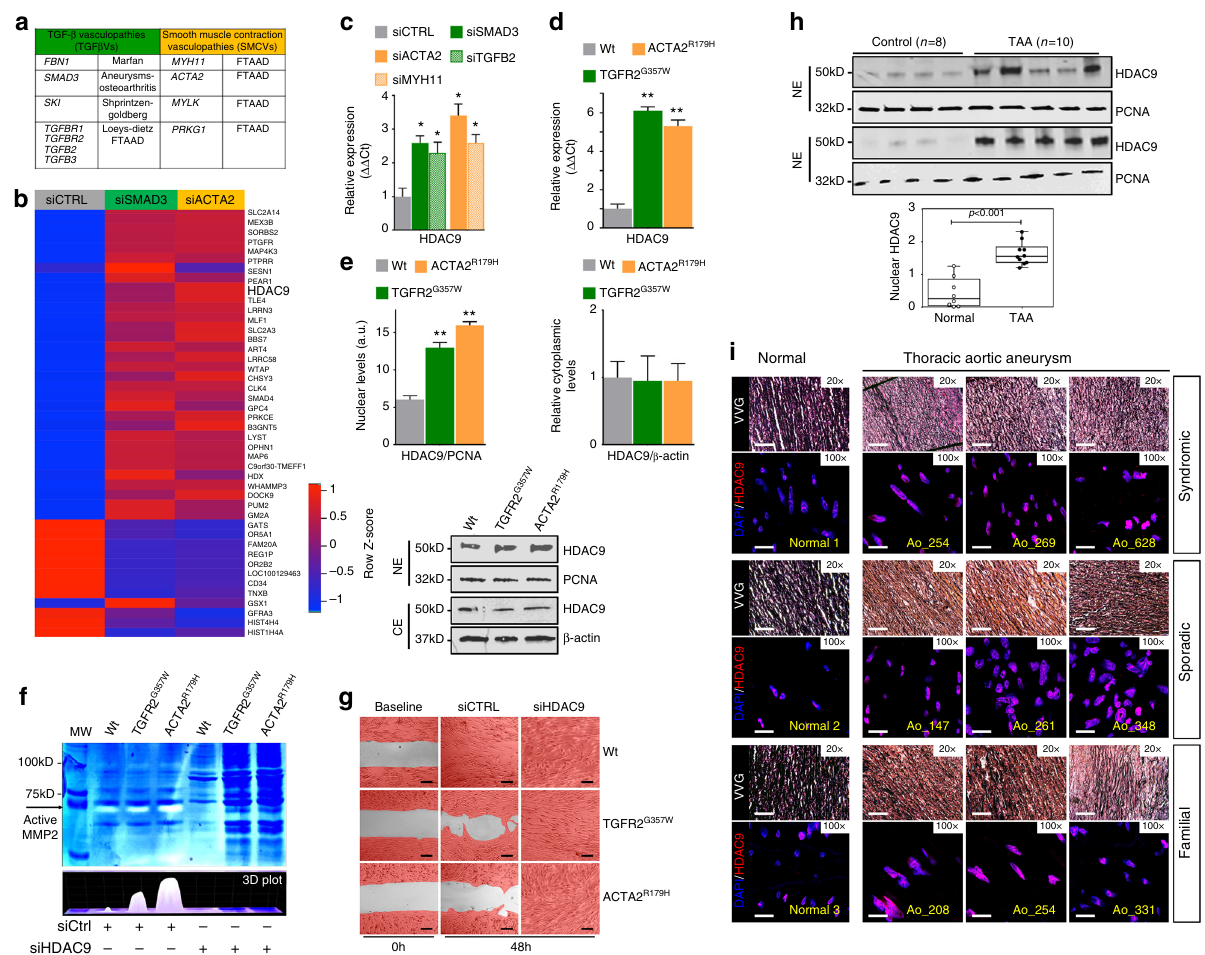
Fig. 1 HDAC9 upregulation is associated with TAA-related human genetic variation. a TGF β Vs and SMCVs gene groups. b Heat map of mRNA expression of commonly dysregulated genes in siSMAD3 (HDAC9 fold change = 1.6) and siACTA2 (HDAC9 fold change = 2.0) treated human VSMCs. The scale bar indicates fold change Z -score. c QPCR validation of HDAC9 transcript induction in siSMAD3, siTGFB2, siACTA2 and siMYH11 treated cells. Four experimental replicates are plotted. d QPCR analysis of HDAC9 transcript in human VSMCs transfected with either empty vector, TGFR2 G357W , or ACTA2 R179H alleles. Four experimental replicates are plotted. e Quantitative western blot analysis of HDAC9 distribution in nuclear and cytoplasmic extracts demonstrates increased nuclear localization in the presence of TGFR2 G357W or ACTA2 R179H alleles. Three experimental replicates are quanti fi ed. f siHDAC9 treatment of VSMCs reverses MMP activity induced by expression of TGFR2 G357W or ACTA2 R179H alleles in human VSMCs as measured by in vitro gelatin zymography. g siHDAC9 treatment of VSMCs rescues inhibition of migratory activity induced by expression of TGFR2 G357W or ACTA2 R179H alleles in human VSMCs as assayed by wound healing assay. Serial photomicrographs of wound healing assay at 0 and 48 h are shown, VSMCs are false colored in red. Bar = 200 µ M. h Quantitative western blot analysis of HDAC9 protein in nuclear extracts from human aortic tissue from TAA patients and non-aneurysmal controls. i Immuno fl uorescence staining demonstrates similar nuclear localization of HDAC9 protein in human TAA samples from diverse forms of TAA etiology. Aortic lumen is rightward facing. (20×, Bar = 50 µ M; 100×, Bar = 10 µ M). FTAAD, Familial Thoracic Aortic Aneurysms and Dissections; TAA, Thoracic Aortic Aneurysm. Bar graphs are presented as mean with error bars (±S.D.), Student ’ s T -test, * p < 0.05, ** p < 0.01 vs. WT. Full-length western blots presented in Supplementary Fig.